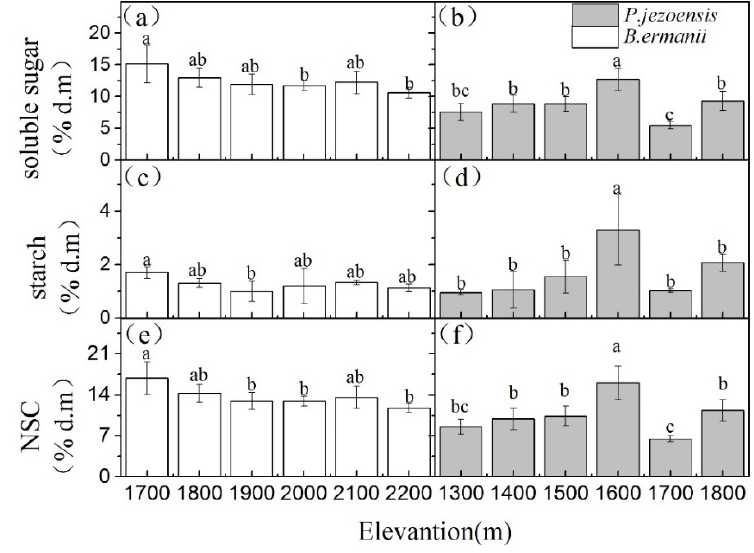
Figure 2. Variation in the concentrations of B. ermanii leaves ( a ) soluble sugar, ( c ) starch and ( e ) NSC as well as P. jezoensis leaves ( b ) soluble sugar, ( d ) starch and ( f ) NSC (mean ± SD; % of dry matter) along with elevational gradients in Changbai Mountain ( n = 5 for each elevational site). Di ff erent letters indicate significant di ff erences ( p < 0.05) among elevations as determined by Tukey’s Honestly Significant Di ff erence (HSD) test single-factor ANOVAs.